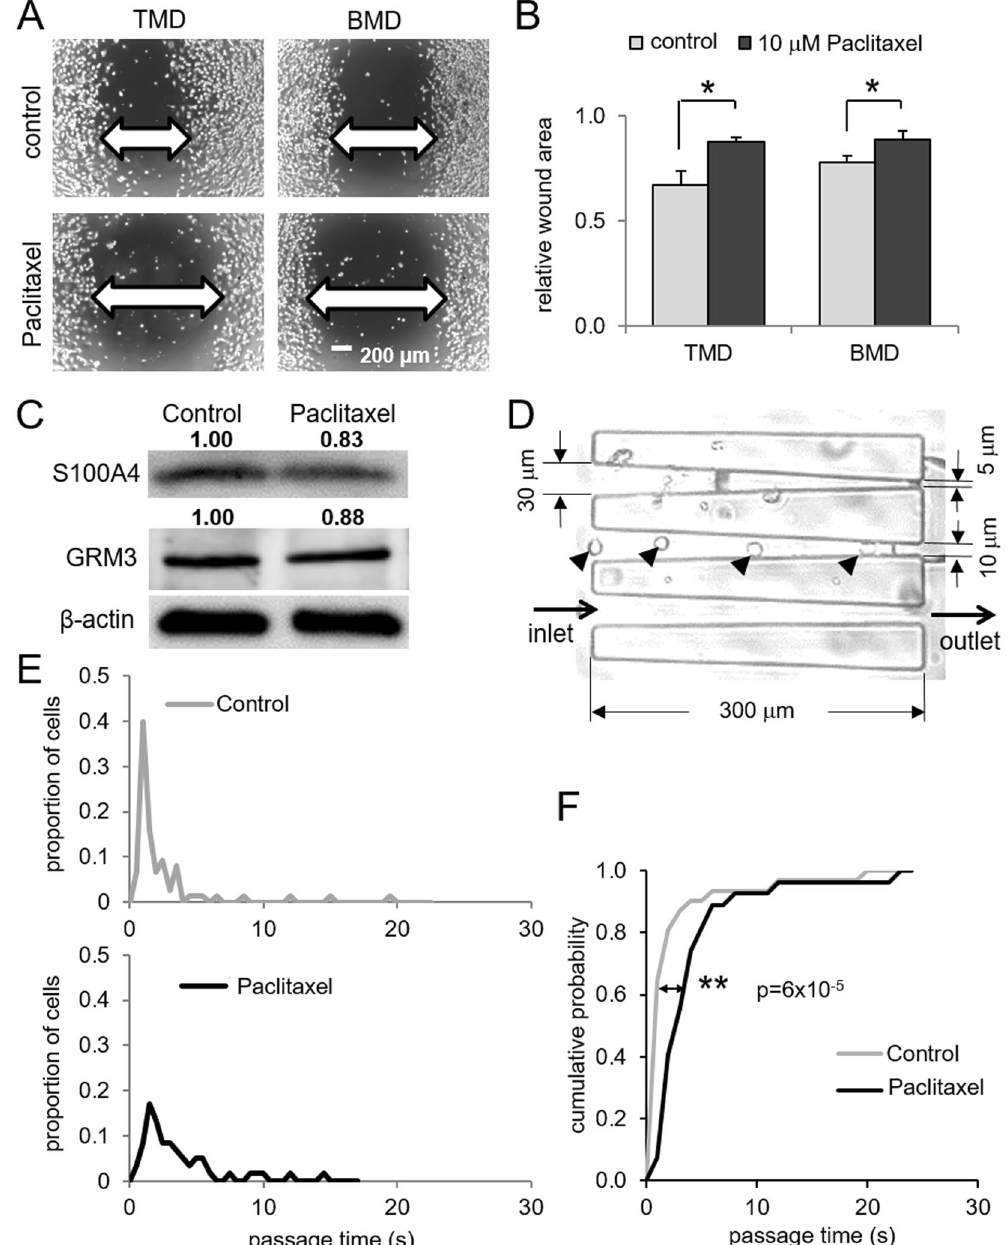
Figure 6. Effects of Paclitaxel in cellular motility, S100A4 expression, and passing behavior in a microfluidic channel. The single and double asterisks indicate p < 0.05 and p < 0.01, respectively. ( A , B ) Reduction in 2-dimensional cellular motility by 10 µ M Paclitaxel in TMD cells and BMD cells. ( C ) Reduction in S100A4 protein level by 10 µ M Paclitaxel in TMD cells. ( D ) Microfluidic channel for evaluating passing behaviors of TMD cells with and without Paclitaxel treatment. The arrow head indicates individual TMD cells in the channel. ( E ) Histogram of a passing time in a 300- µ m channel for TMD cells (control) and Paclitaxel-treated TMD cells. ( F ) Longer passing time for Paclitaxel-treated TMD cells than control